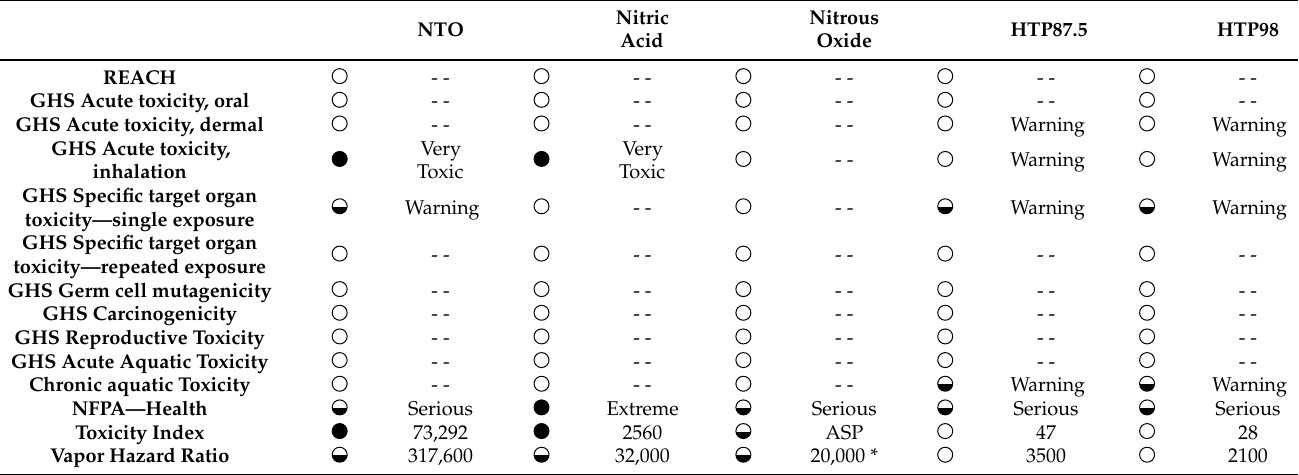
Table 9. Oxidizers toxicity metrics.